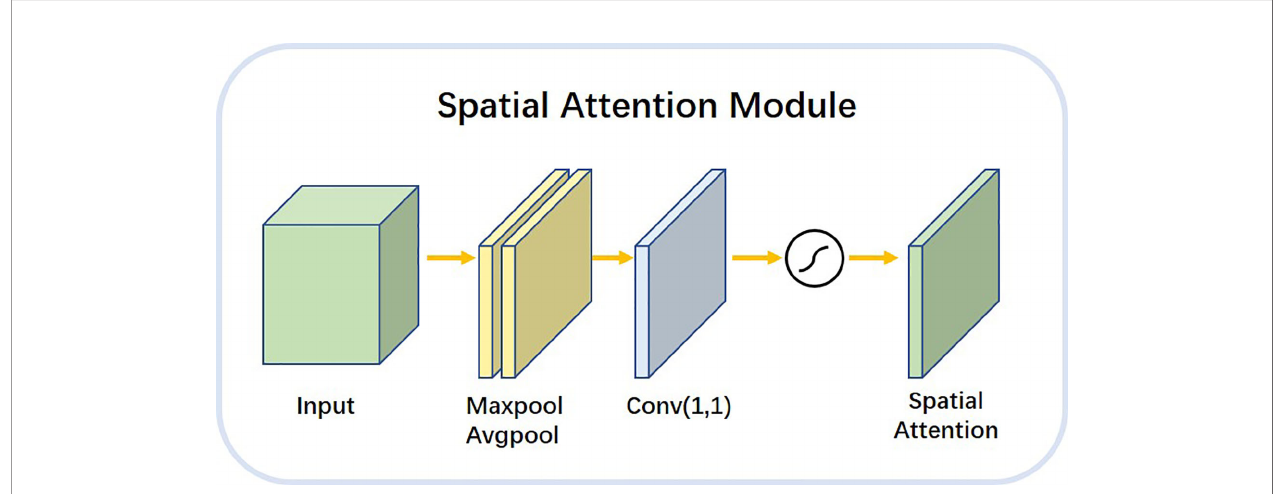
FIGURE 8 | Architecture diagram of spatial attention